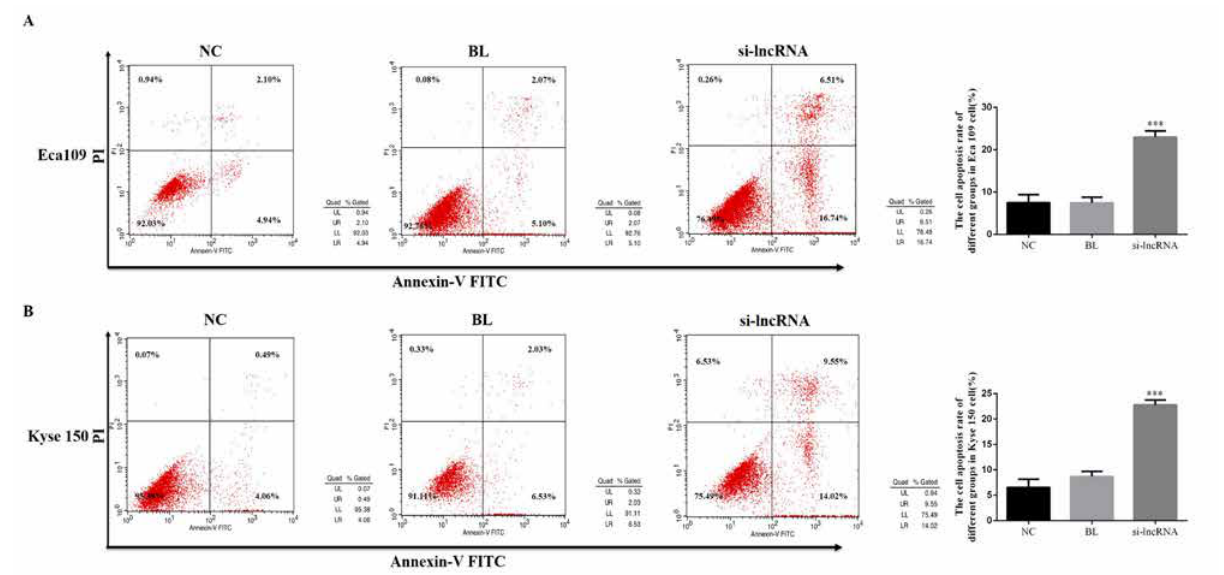
Figure 3. Cell apoptosis measurement by flow cytometry in Eca 109 and Kyse 150 cells. NC: Normal control group; BL: Blank group; si-lncRNA: si-lncRNA LINC00152 group A. The Eca 109 cell apoptosis rate of difference groups by flow cytometry. ***: P<0.05, compared with NC group. B. The Kyse 150 cell apopto- sis rate of difference groups by flow cytometry. ***: P<0.05, compared with NC group.